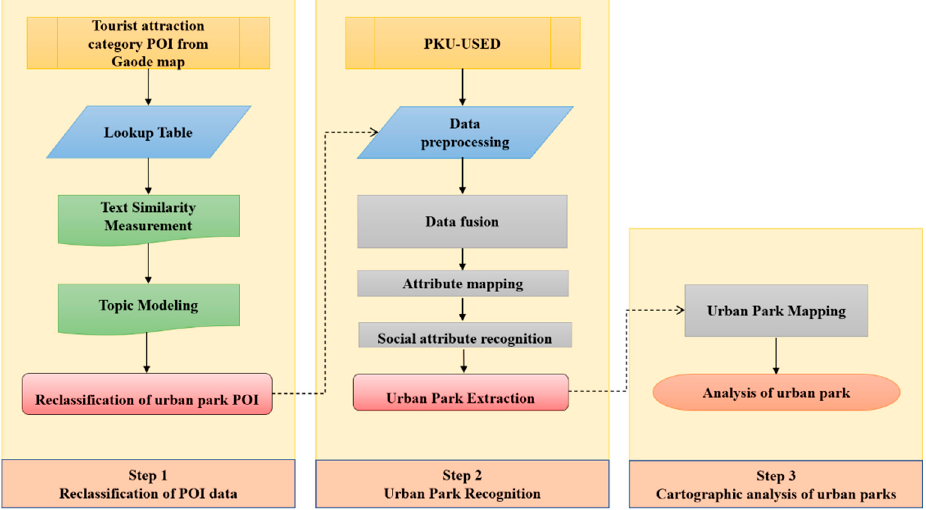
Figure 5. Urban park classification process.